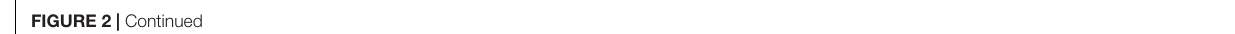
figure legends. The experimenter blinded to the genotype performed all